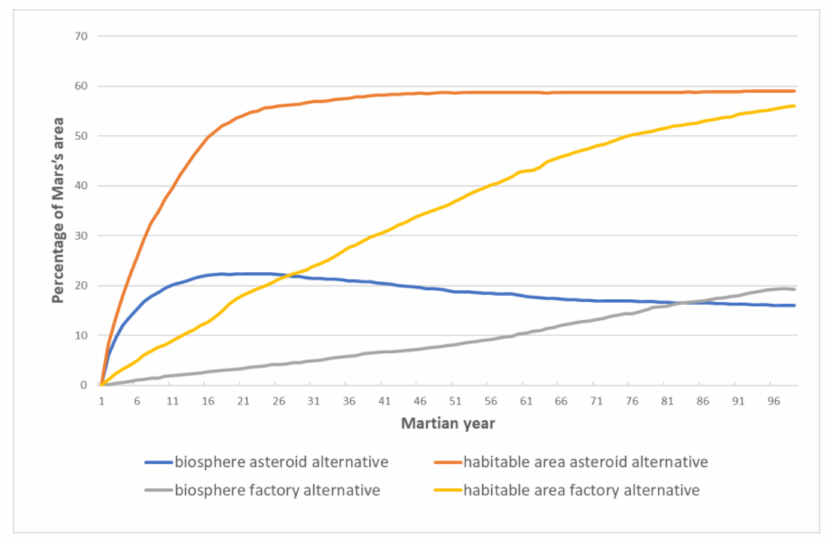
Figure 13. Percentage of Mars’s area with an average temperature above − 25 ◦ C (habitable area) and above 0 ◦ C (biosphere).